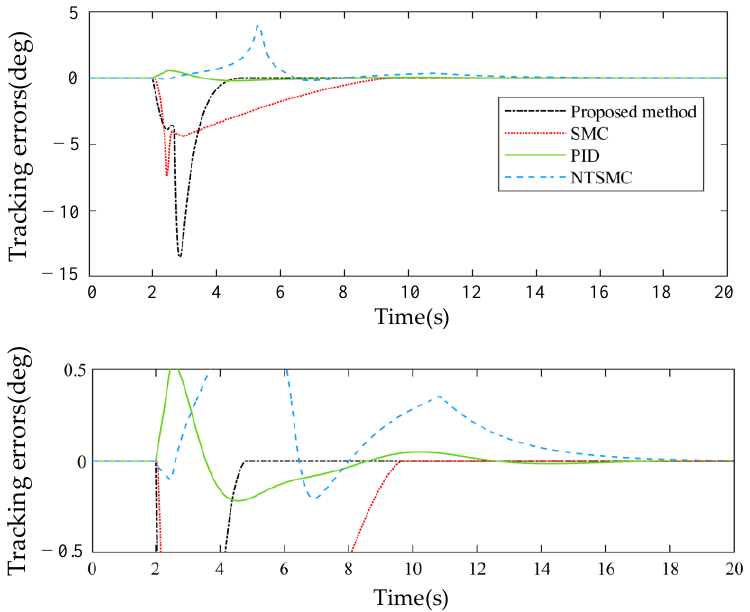
Figure 6. Attitude tracking error for different controllers of joint 1.